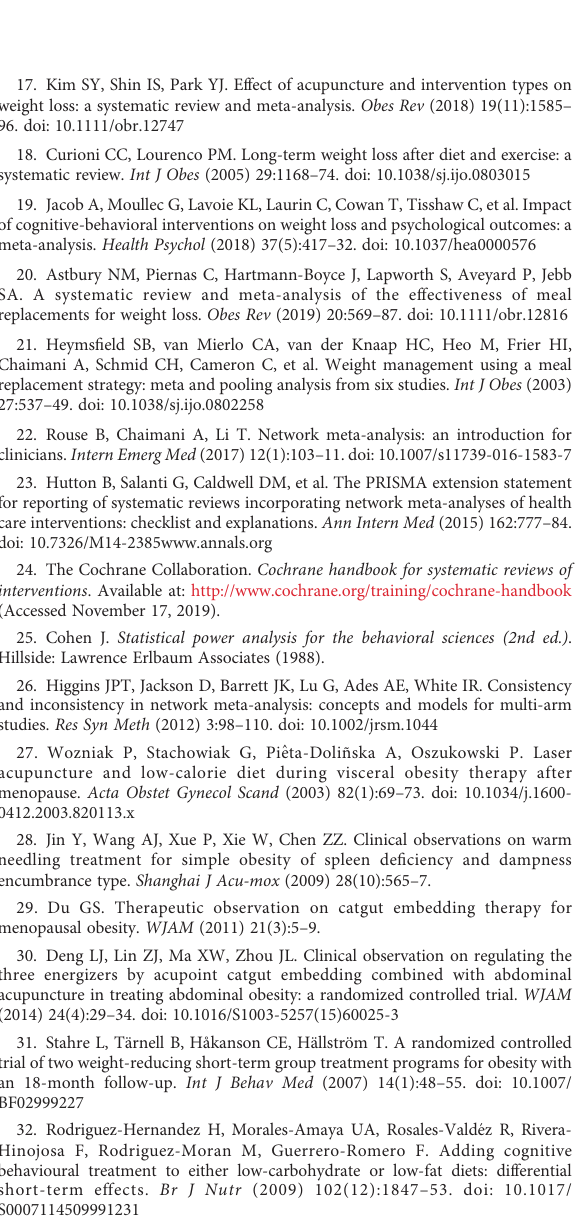
SUPPLEMENTARY FIGURE 1 Rankograms of each intervention. LCD, low-calorie diet; CBT, cognitive behavioral therapy; MR, meal